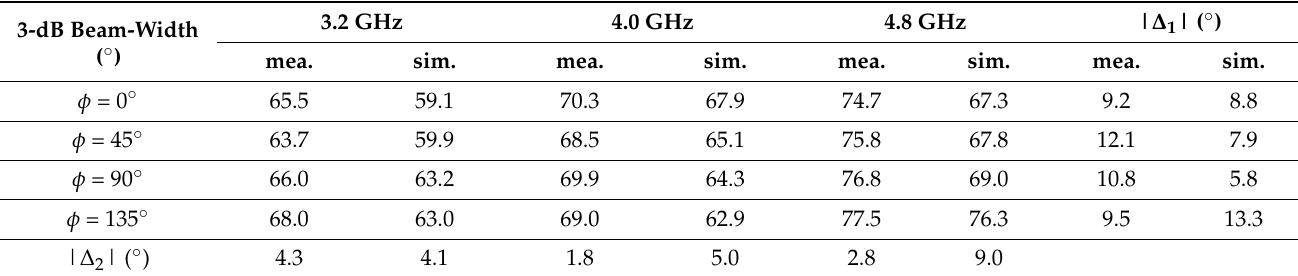
Table 2. Measured and simulated 3-db beamwidth at low-, mid-, and high-frequency points. 3-dB